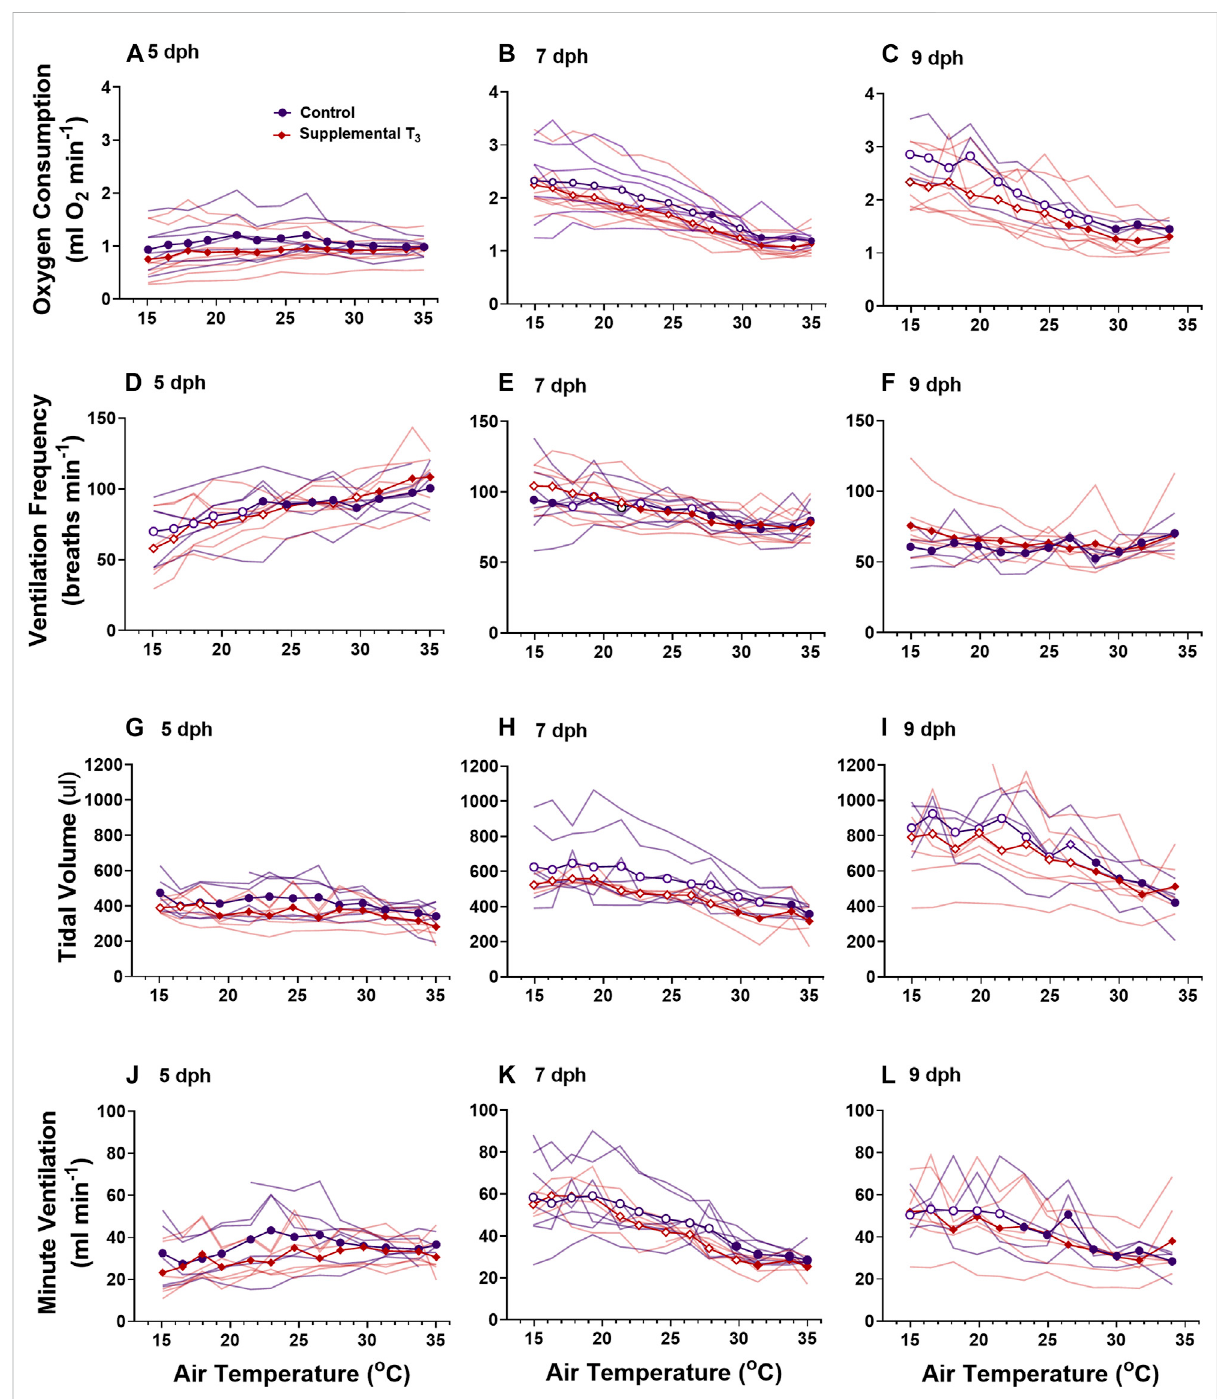
FIGURE 5 Theontogenyofoxygenconsumption (A – C) ,ventilationfrequency (D – F) ,tidalvolume (G – I) ,andminuteventilation (I – K) werenotaffectedby supplemental T 3 . There was no effect of T 3 treatment on metabolism or ventilation. Data presented as means plus individual responses. Within a treatment, open symbols represent large or greater effects of temperature based on Cohen ’ s d effect sizes > 0.8 compared with the thermal neutral value. n = 5 per